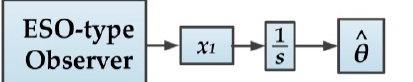
Figure 11. Time evolution of the PMSM rotor speed estimation.